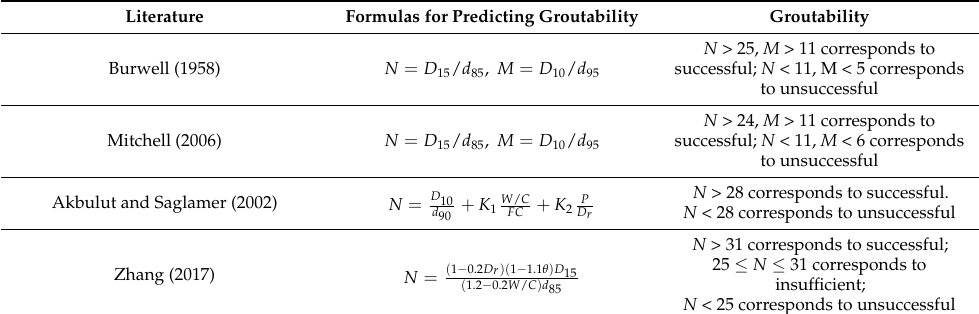
Figure 2. Grouting mode in sand layer. ( a ) Permeation mode. ( b ) Fracture–compaction mode. Table 1. Groutability criteria of sand.